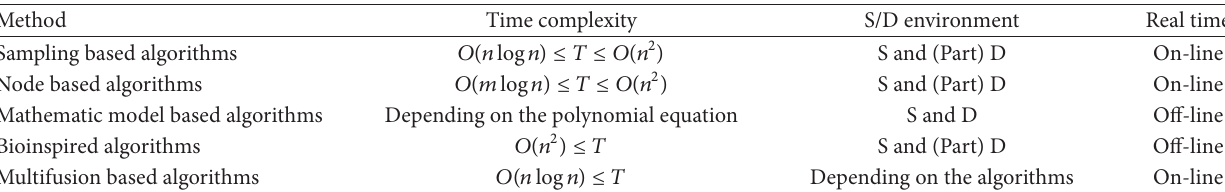
Table 7: Properties of each kind of